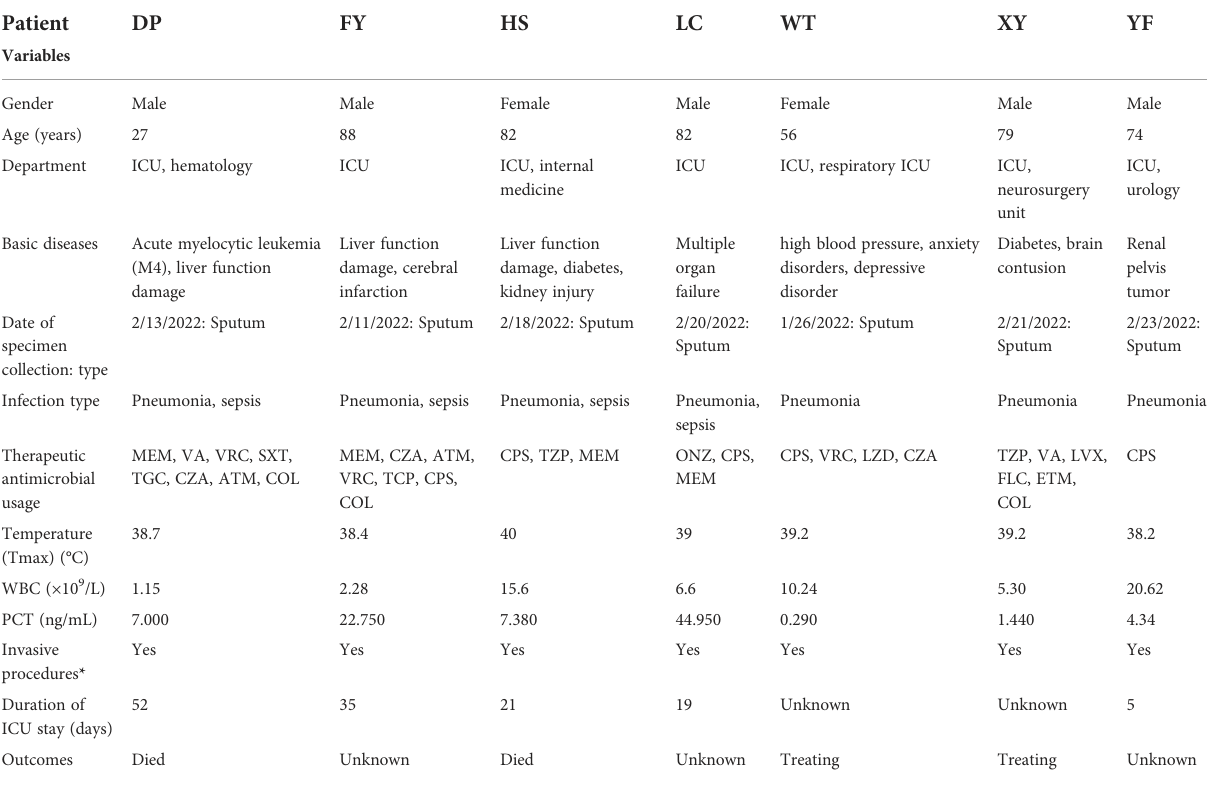
TABLE 1 Clinical characteristics of patients with XDR-HvKp